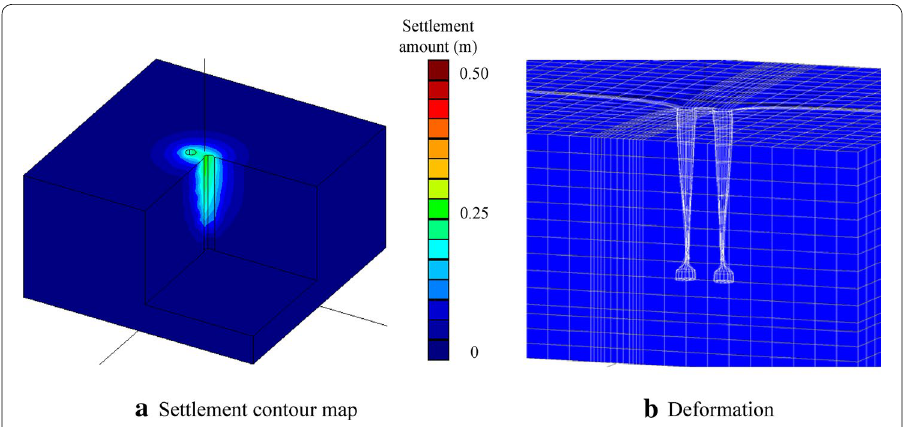
Fig. 3 Deformation behavior of surrounding ground when two pullout holes are hollow. a Settlement contour map. b Deformation